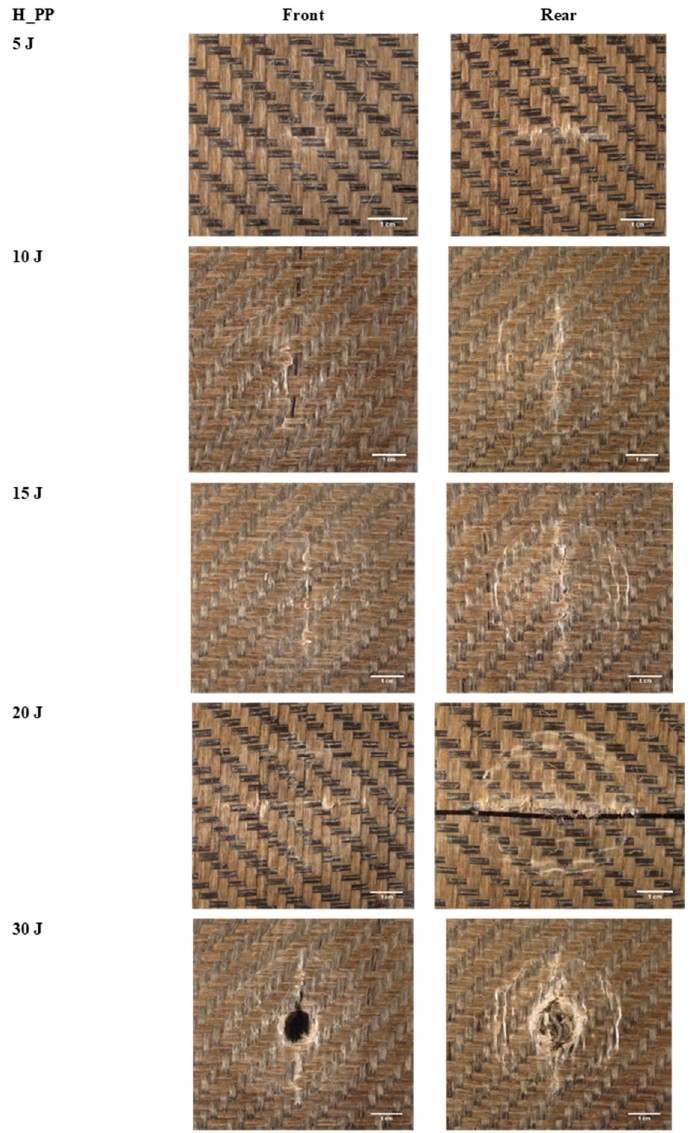
Figure 12. Close-up view of impact damage progression on front and rear surfaces of PP-based impacted specimens.